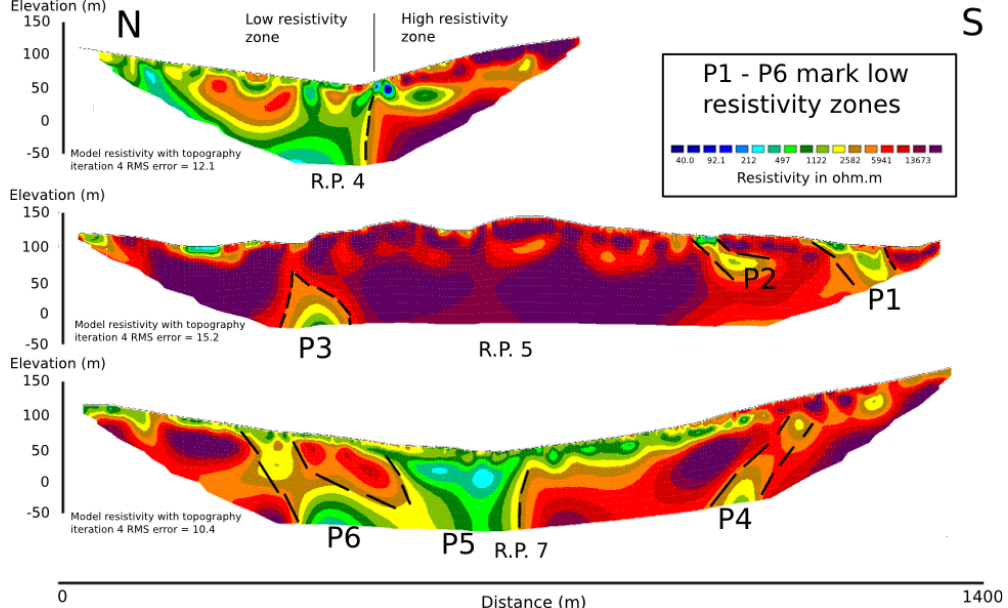
Fig. 13. Resistivity profiles 4, 5 and 7 (R.P. 7 reinterpreted from Nasuti et al., 2011). For low resistivity zones marked P1–P6 see text for discussion. Length to depth ratio approximately 1:1.